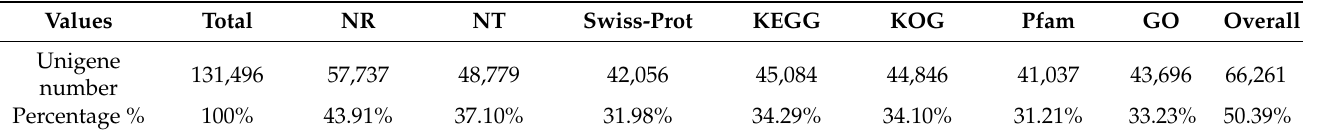
Table 2. The annotations of tree peony unigenes against the public